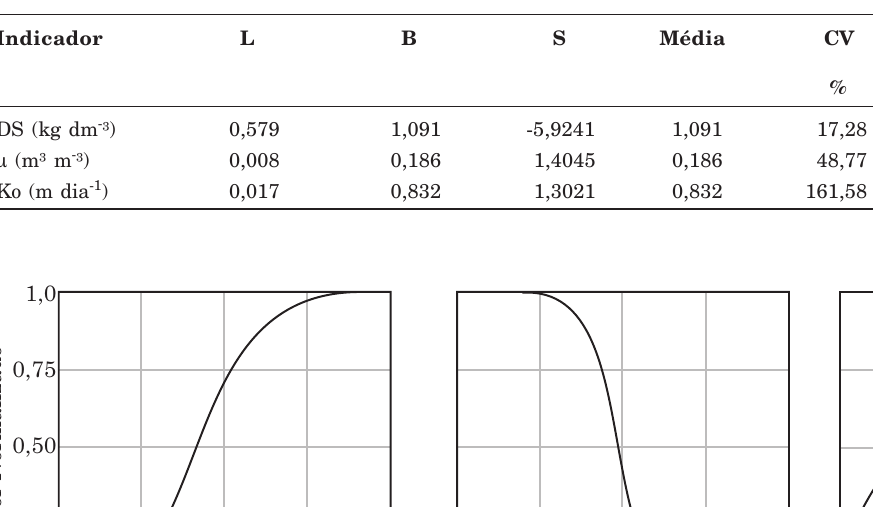
Quadro 1. Valores dos parâmetros L, B e S aplicados para normalização dos indicadores utilizados no cálculo do índice de qualidade do solo associado à recarga de água subterrânea (IQS RA ) e estatísticas básicas